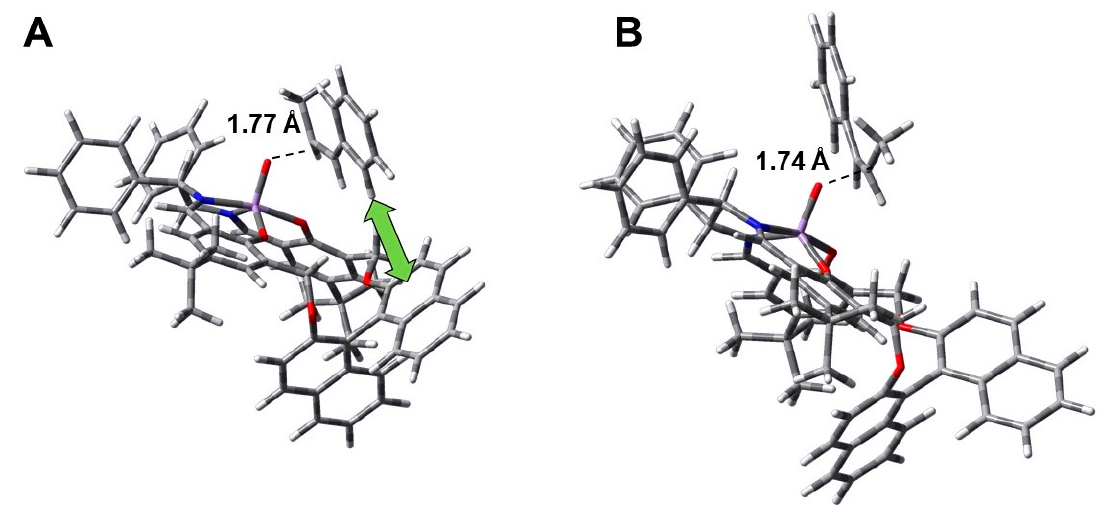
Figure 4. Three-dimensional plots of the two enantiomeric transition states for the epoxidation of cis- β -methyl-styrene with Mn-M20 leading to the ( 2S,3R ) ( A ) and the ( 2R,3S ) ( B ) epoxides, respectively. The green arrow highlights the CH– π interaction between the alkene and the aromatic ring of the BINOL compound.